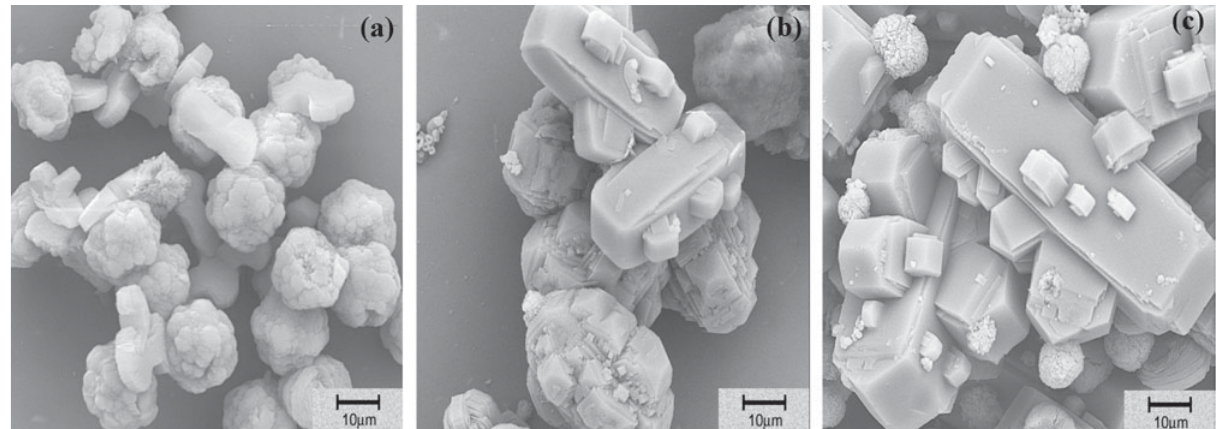
Figure 2. SEM micrographs of precursor Na/ZSM-5 having a Si/Al ratio equal to: (a) 11, (b) 23 and (c)